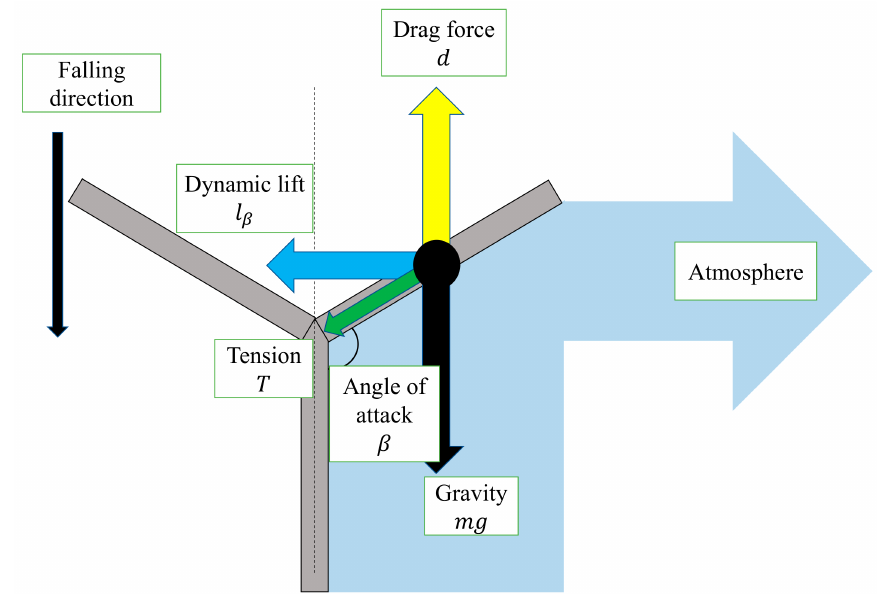
Figure 8. Lift force l β due to angle of attack β